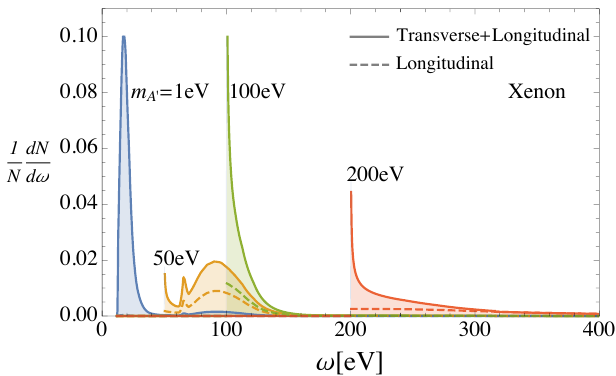
Figure 2 . The normalized spectra of the total number of events for dark photons ( A 0 ) from the Sun in a xenon detector. The combined transverse and longitudinal modes ( solid ) and the longitudinal mode alone ( dashed ) are shown for m A 0 = 1 ; 50 ; 100 ; and 200 eV. The spectrum of the m A 0 = 1